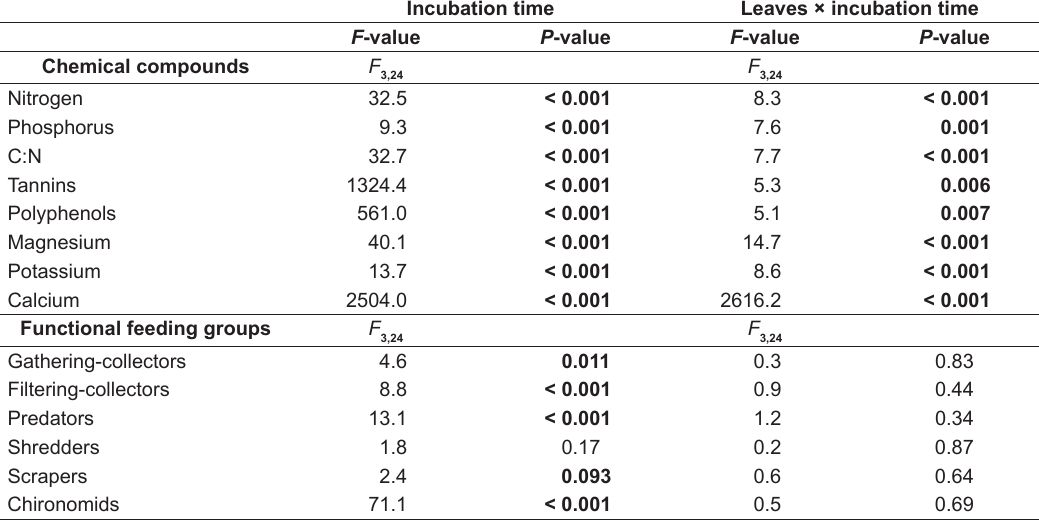
Table 2. Summary for two-way ANOVAs results to test for changes in concentration of leaf chemical compounds and the density of each functional feeding group during breakdown.